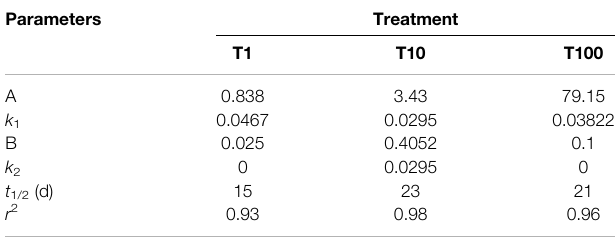
TABLE 1 | Kinetic parameters of tri fl uralin degradation in soil at three different concentrations. Parameters